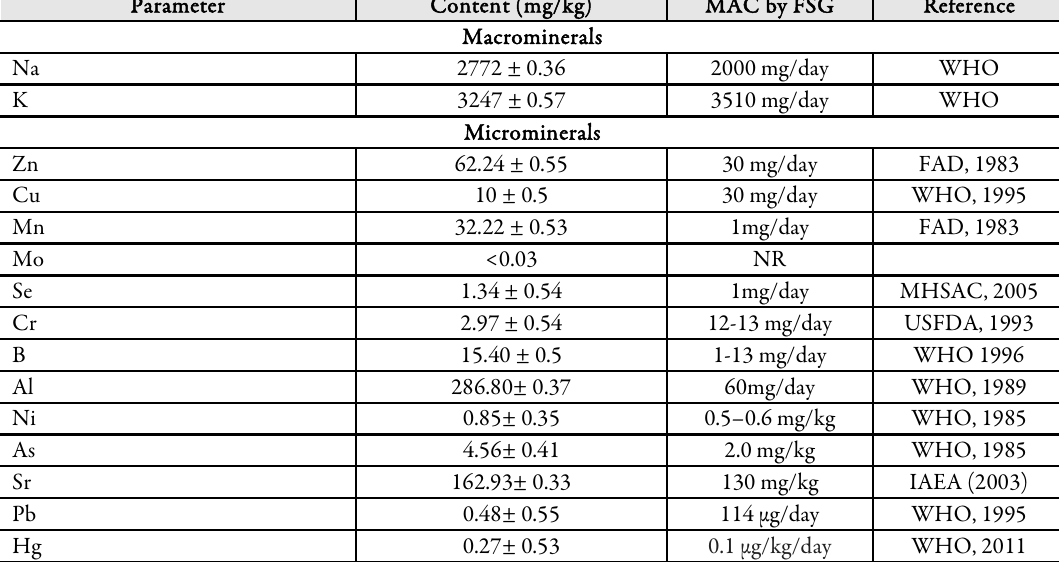
Table 2. The mineral composition of S. pharaonis Parameter Content (mg/kg) MAC by FSG Reference